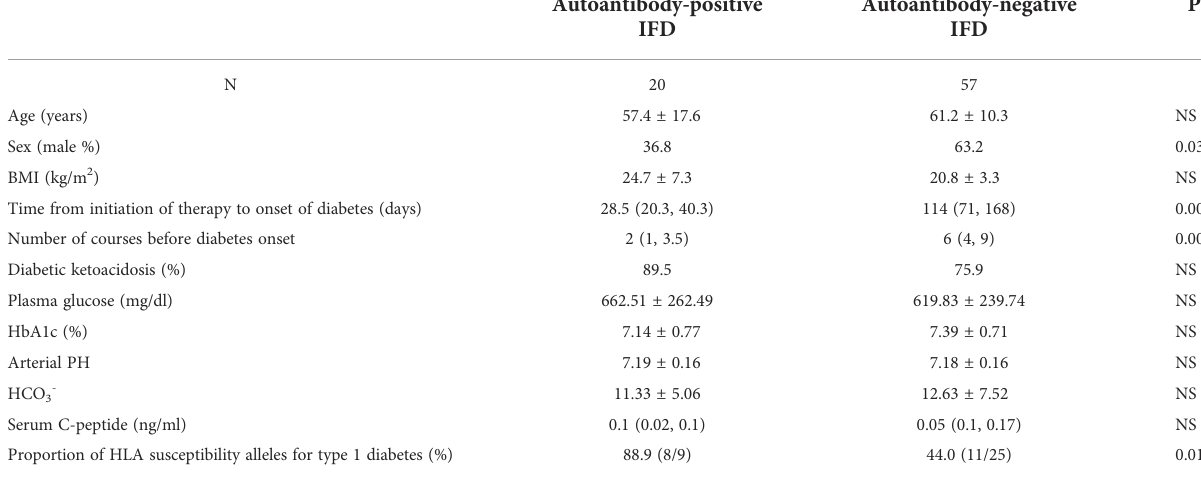
TABLE 3 The clinical and biological characteristics of IFD in different autoantibody